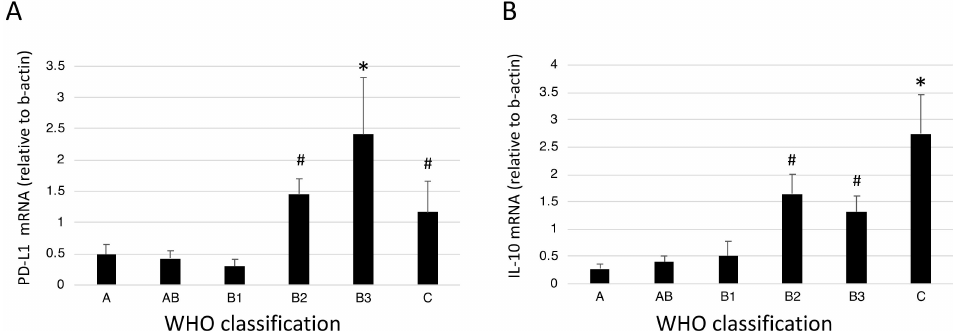
Figure 5. PD-L1 and IL-10 mRNA expression according to the WHO classification of TET. ( A ) PD-L1 expression. ( B ) IL-10 expression. RNA was isolated and mRNA expression was quantified with regard to mRNA expression of β -actin by using real-time PCR. Error bars represent the SDs of the means. * p < 0.05 compared to all other TETs. # p < 0.05 compared to lower grades (types A, AB, and